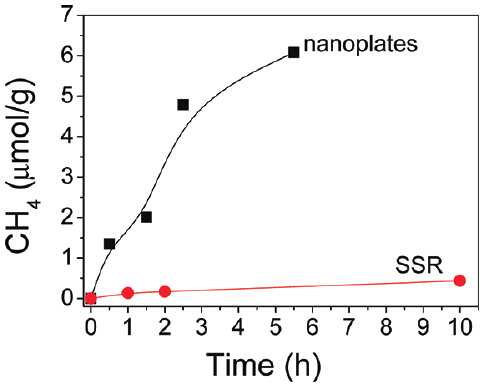
Figure 7. CH 4 yields on Bi 2 WO 6 photocatalysts. Reprinted with permission from Ref. [97]. Zhou, Y.; Tian, Z.; Zhao, Z.; Liu, Q.; Kou, J.; Chen, X.; Gao, J.; Yan, S.; Zou, Z.